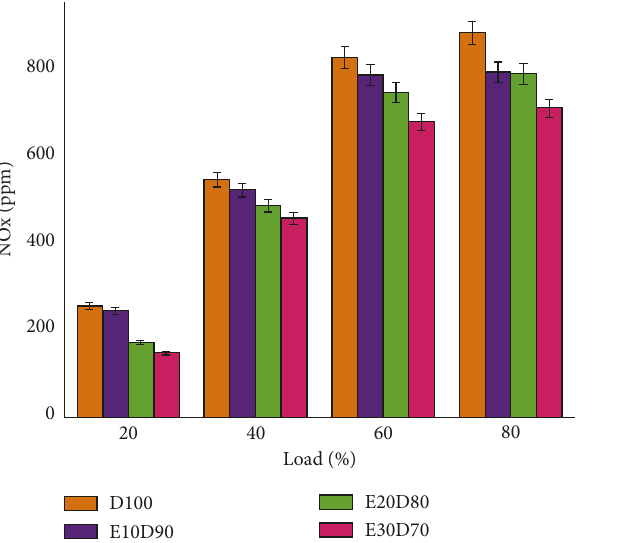
Figure 15: Variation in NO